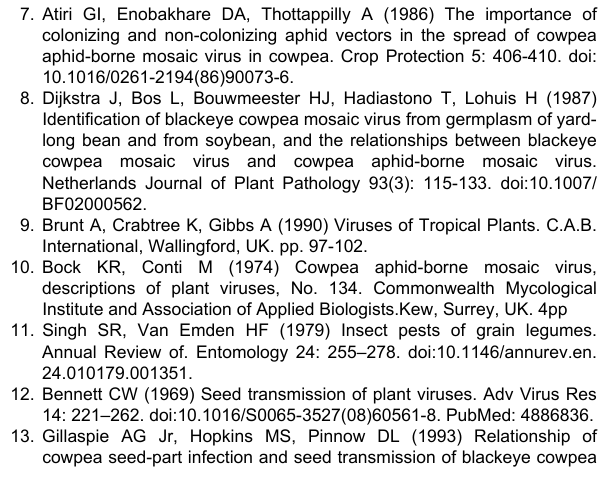
Table S2. InterproScan results from A. craccivora contigs that showed BLASTn hits to B. aphidicola .